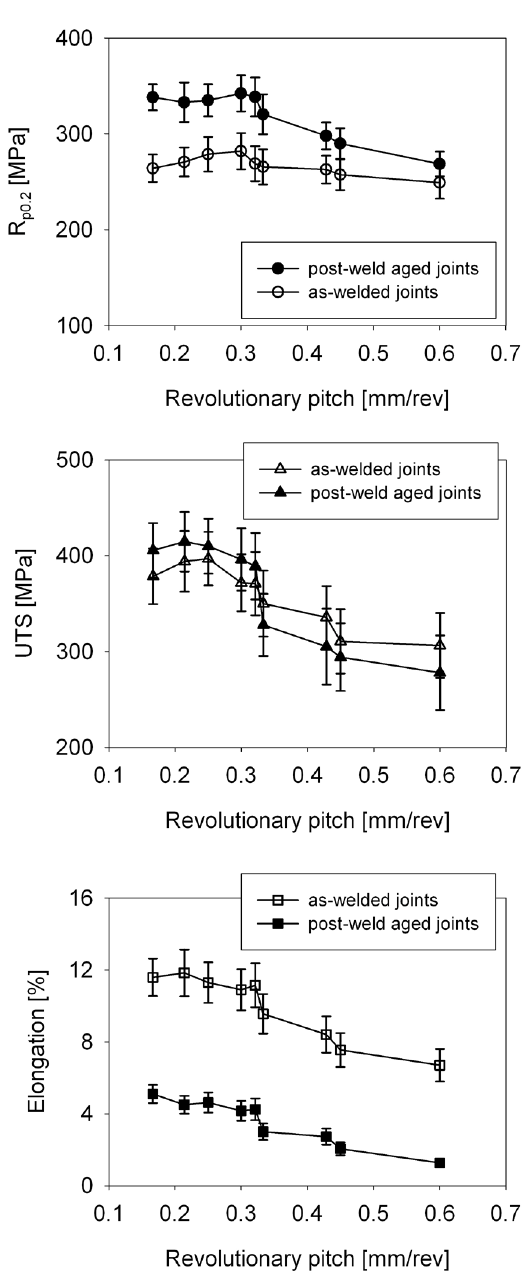
Figure 4. Comparison between the tensile properties of as-welded joints and post-weld aged joints (median over four specimens, the 80% confidence limits are